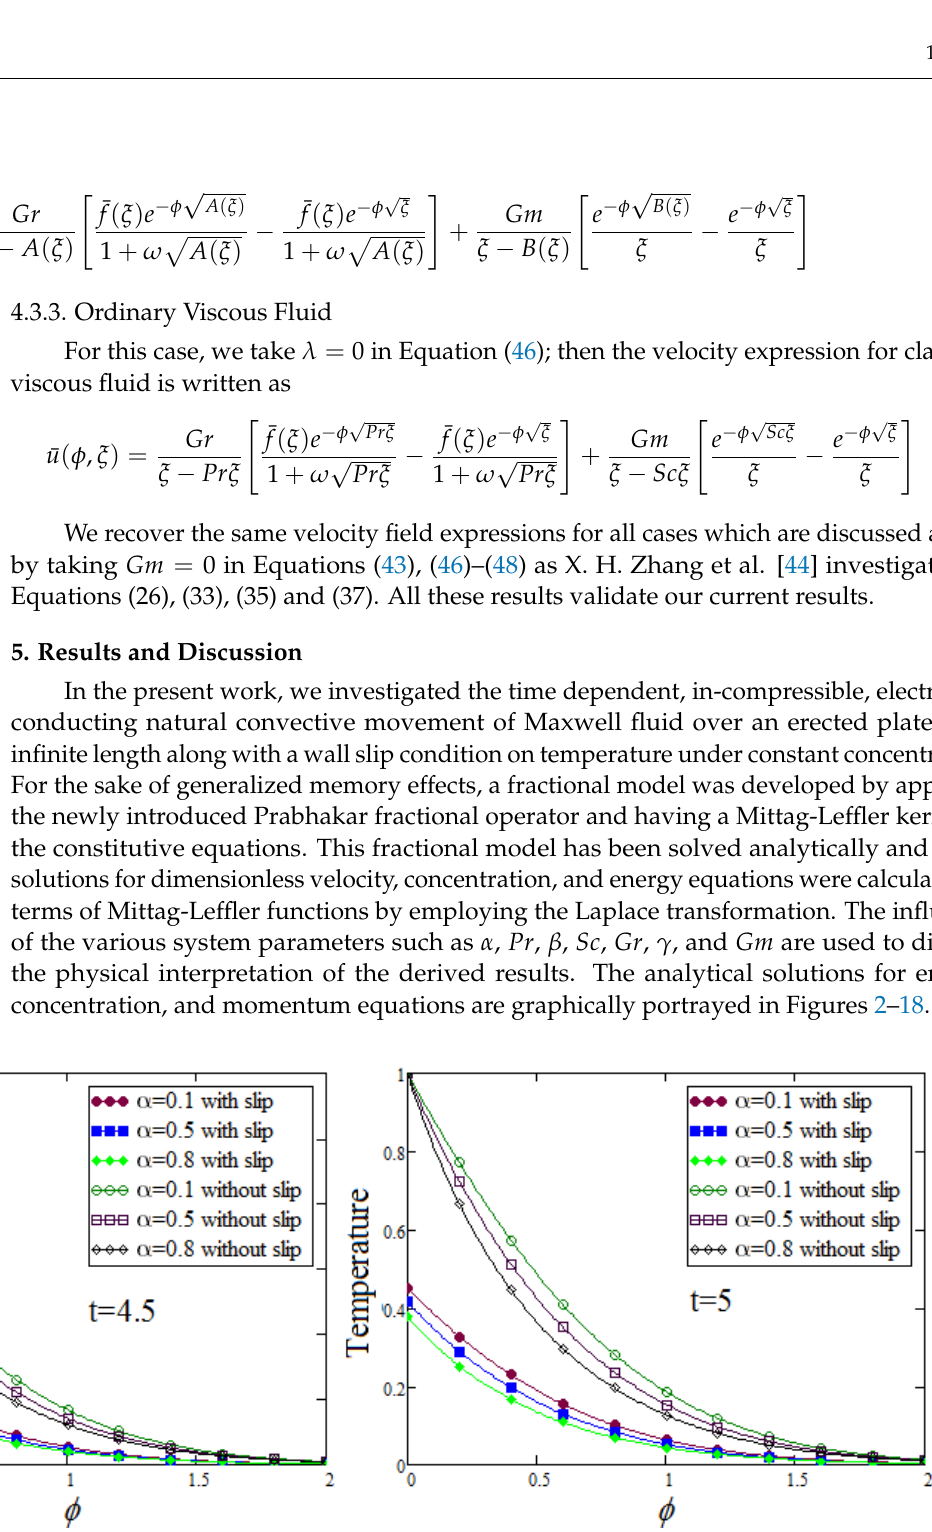
Figure 2. Graphical representations of temperature profile in the presence of slip and no slip condi- tions by taking the distinct values of α at two different levels of time, when Pr = 12, β = 0.3, ℘ = 0.4, ω = 0.5, and γ =